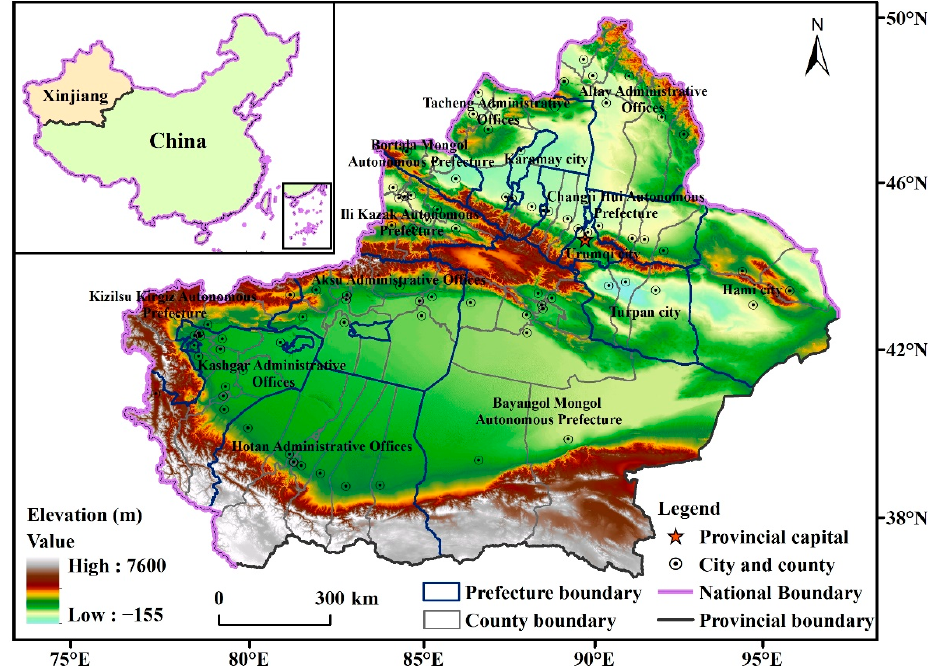
Figure 1. Geographical location and administrative division of Xinjiang.